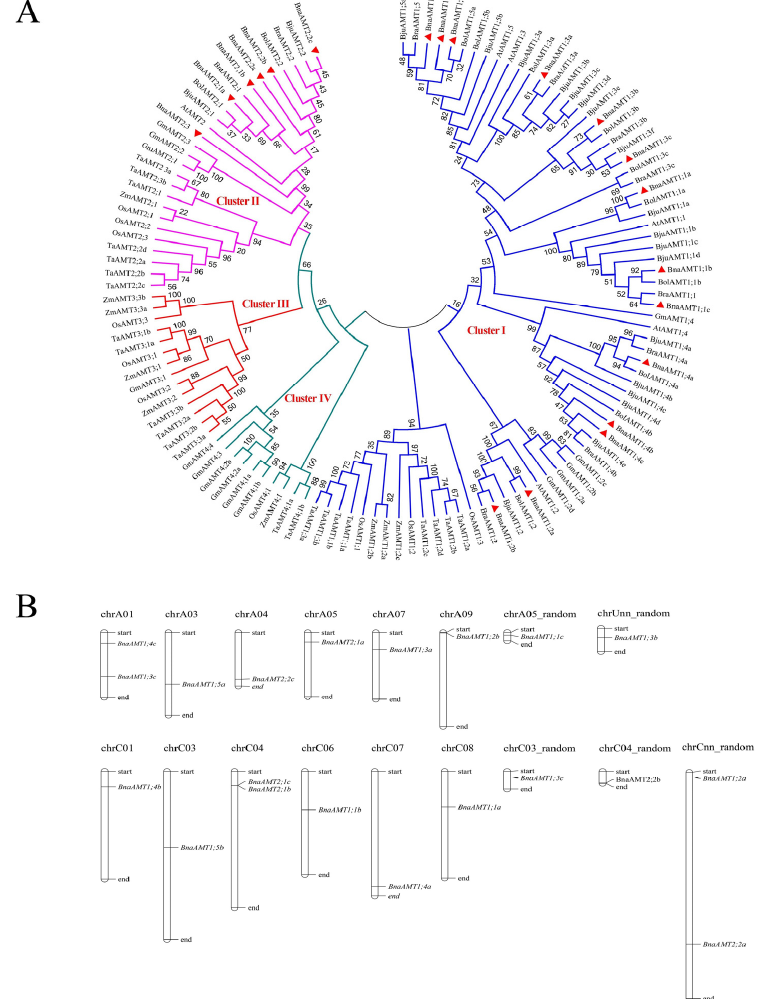
Figure 2. Phylogenetic relationships of AMT family proteins in diverse species and the chromosomal locations of AMT family genes in rapeseed. ( A ) Phylogenetic tree of AMT family proteins. A total of 125 proteins from nine species were used to construct a phylogenetic tree based on the neighbor-joining method in MEGA 7.0 (1000 replicates). From previous reports, 39 AMT family proteins from A. thaliana (At), Oryza sativa (Os), and Triticum aestivum (Ta) were identified. The AMT family proteins from B. napus (Bna), Glycine max (Gm), Zea mays (Zm), B. rape (Bra), B. oleracea (Bol), and B. juncea (Bju) were predicted from these 39 known AMT proteins. Different clusters are labeled by different colors. The 20 aligned BnaAMTs are marked by red triangles. ( B ) Positions of AMT family genes on rapeseed chromosomes.